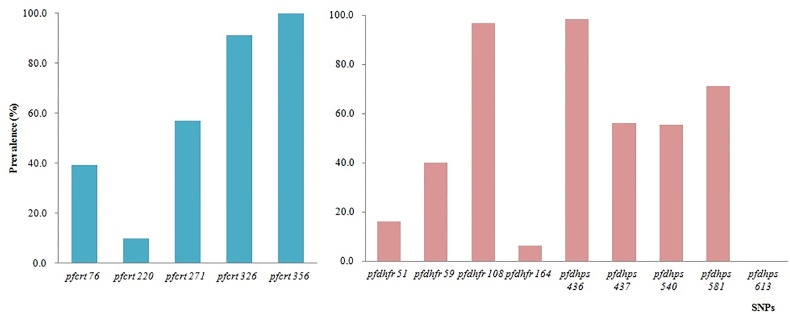
Prevalence of constructed haplotypes of SNPs in pfcrt, pfdhfr, and pfdhps at different codons.